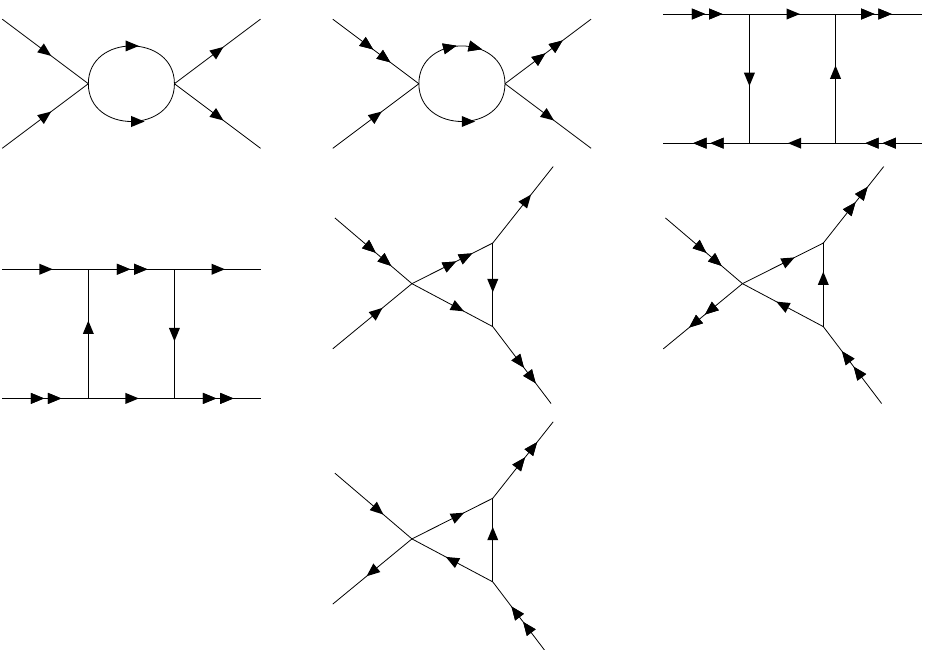
Figure 18. Possible topologies of one-loop corrections to four-point vertices for the dynamical (cid:12)elds. In the picture we do not distinguish between bosonic and fermionic lines. One-loop corrections to four-point